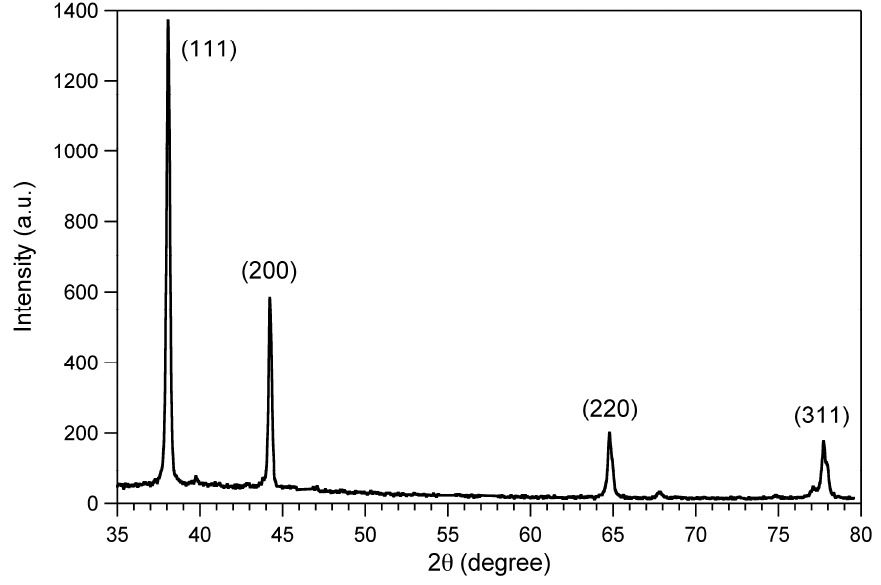
Figure 10. XRD pattern of PVA@AgNW